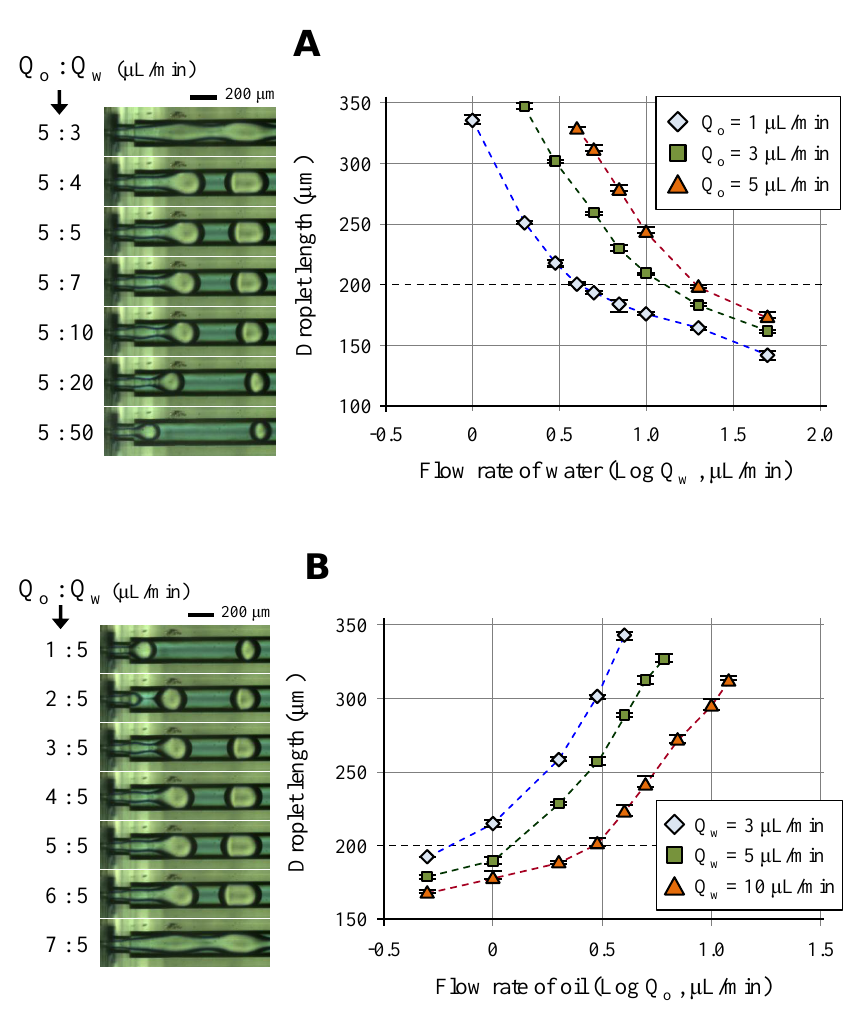
Figure 6. Control of the droplet size via flow rates of continuous phase flow ( A ) and dispersed phase flow ( B